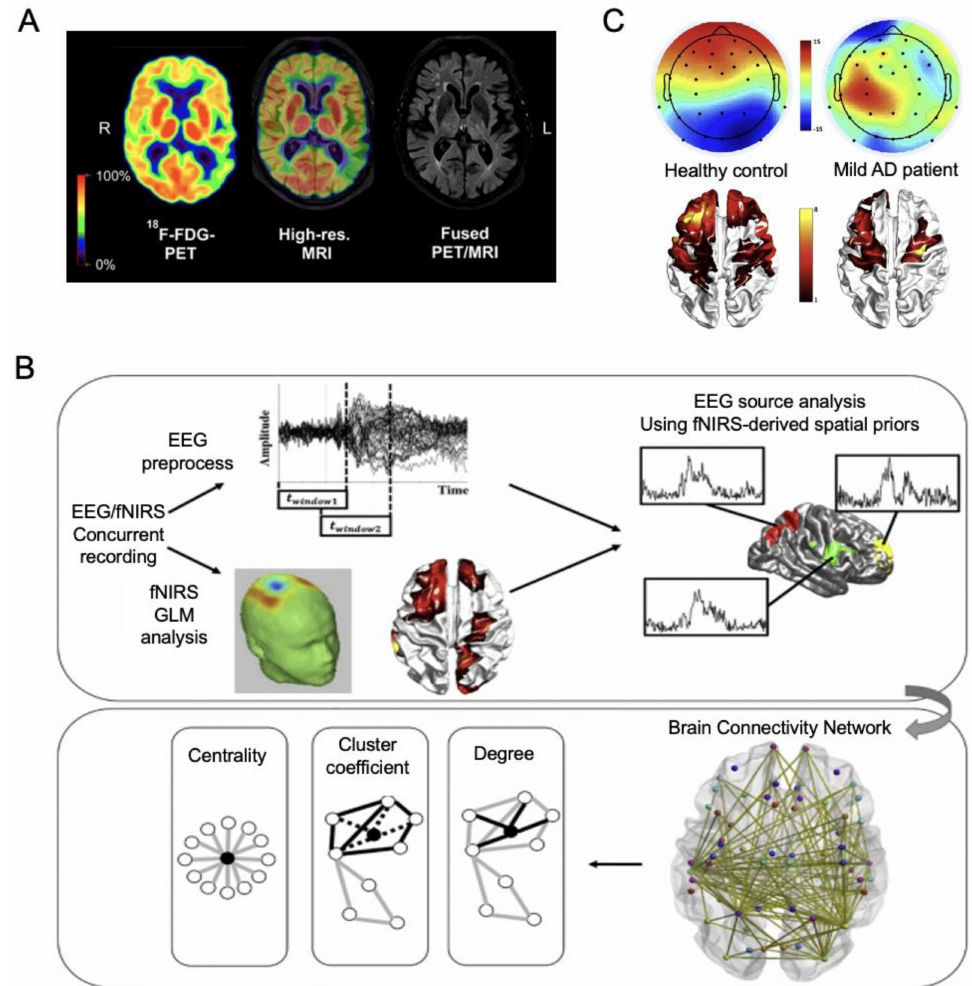
Figure 7. Multimodal Imaging. ( A ) Simultaneous acquisition of PET and MRI images in an AD patient. Adapted from [116] with permission from Society Nuclear Medicine and Molecular Imaging. ( B ) Concurrent recording of EEG and fNIRS and the resulting representative EEG topographies and fNIRS activation maps for the healthy subject and mild AD patient. ( C ) EEG and fNIRS: Dynamic cortical connectivity alterations associated with AD. Adapted from [117] with permission from